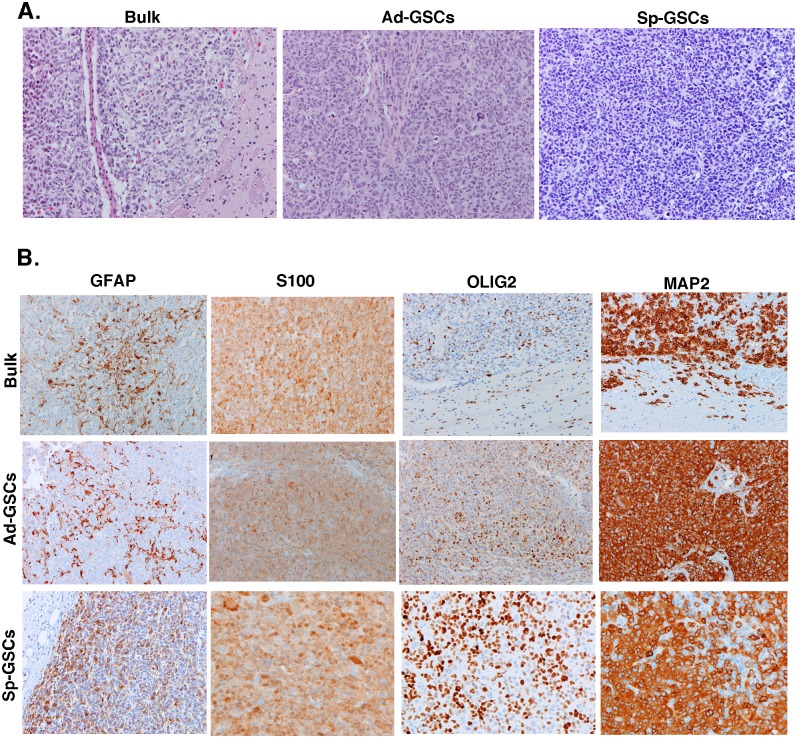
Pathologic analysis of orthotopic GBM6 tumor xenografts.GBM6 bulk tumor cells, Ad-GSCs and Sp-GSCs were orthotopically injected as described in Fig 4, and tumor-bearing brains were paraffin embedded for histology. A. H&E staining and B. Immunoreactivity for GFAP, S100, OLIG2 and MAP2. (All photomicrographs taken at 200x).